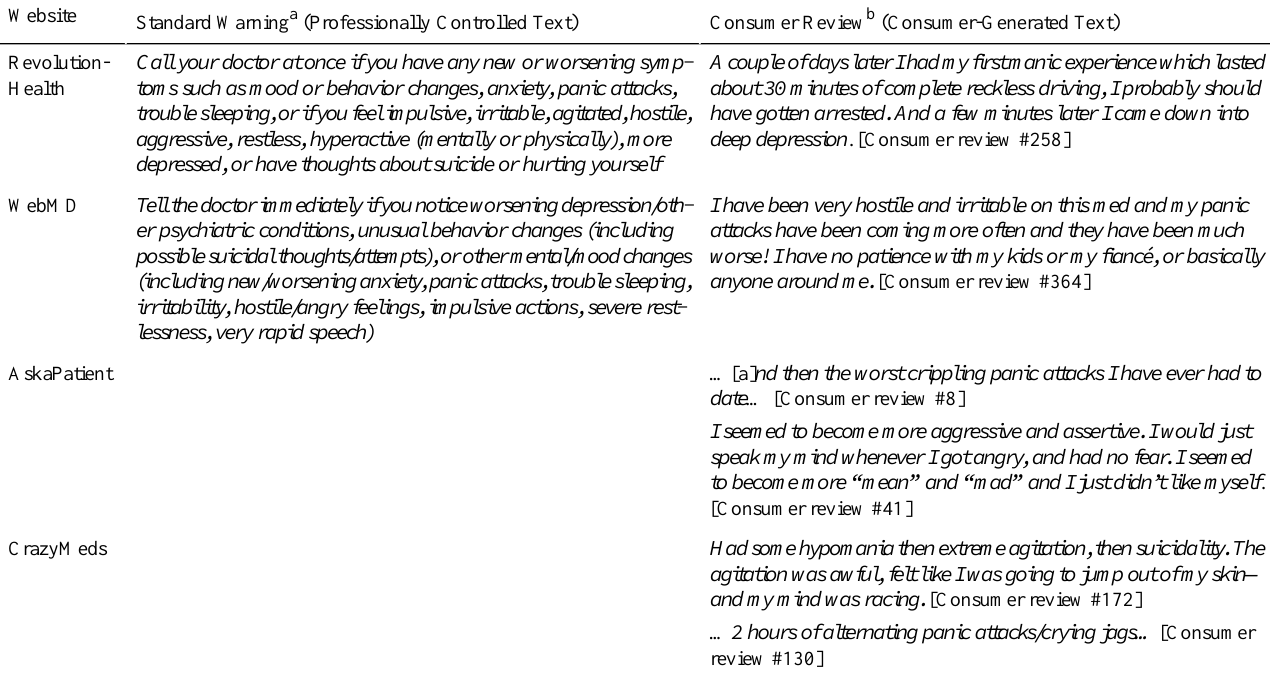
Table 5. Worsening symptoms on escitalopram according to consumer-generated and professionally controlled text